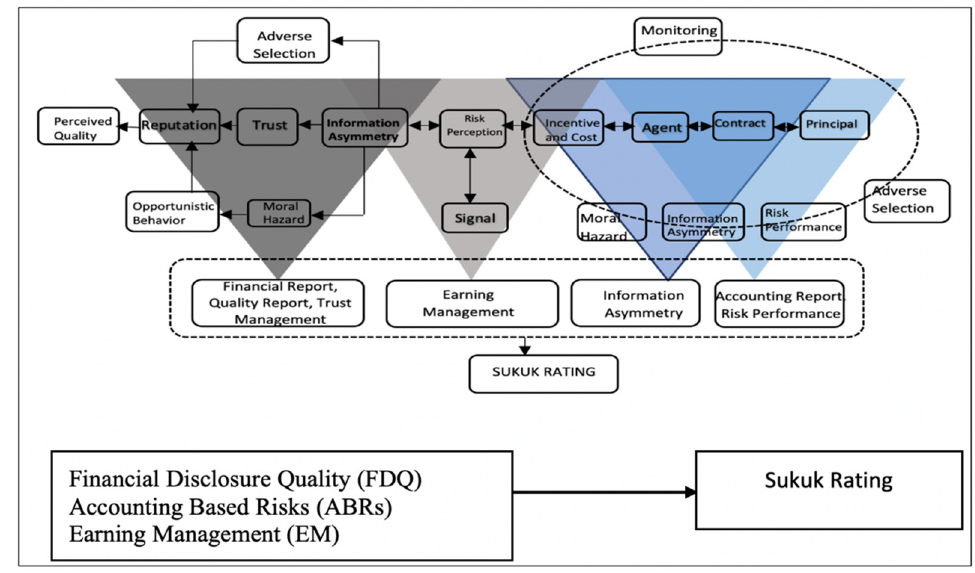
Figure 1. Theoretical Models; the Relationship among Sukuk Ratings and Asymmetry, Agency, and Signaling Theories.